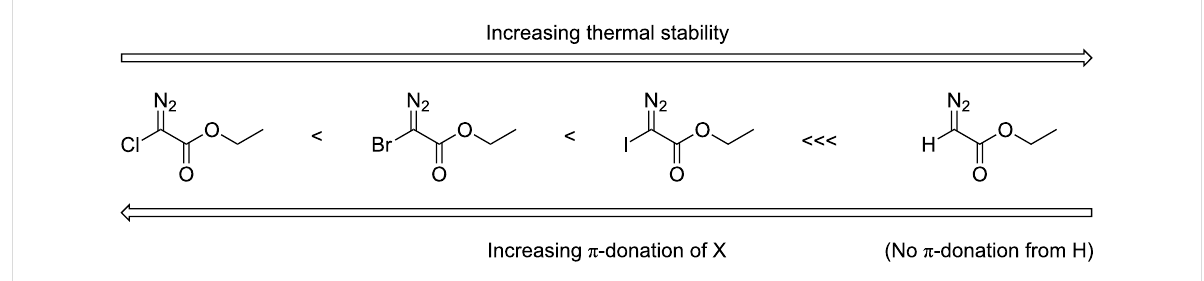
Figure 4: Thermal stability of 1 and 2a – c , and the α -substituents’ contribution to π -donation.